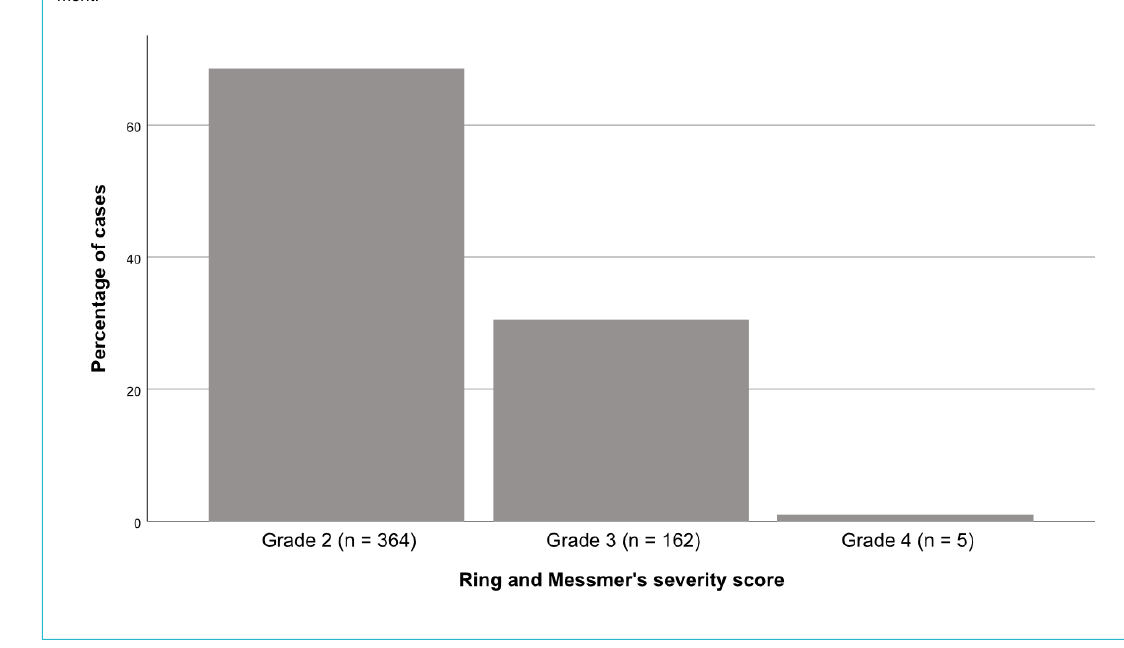
Figure 2: Severity grade according to Ring and Messmer’s classification of the patients with anaphylaxis presenting at the emergency depart-